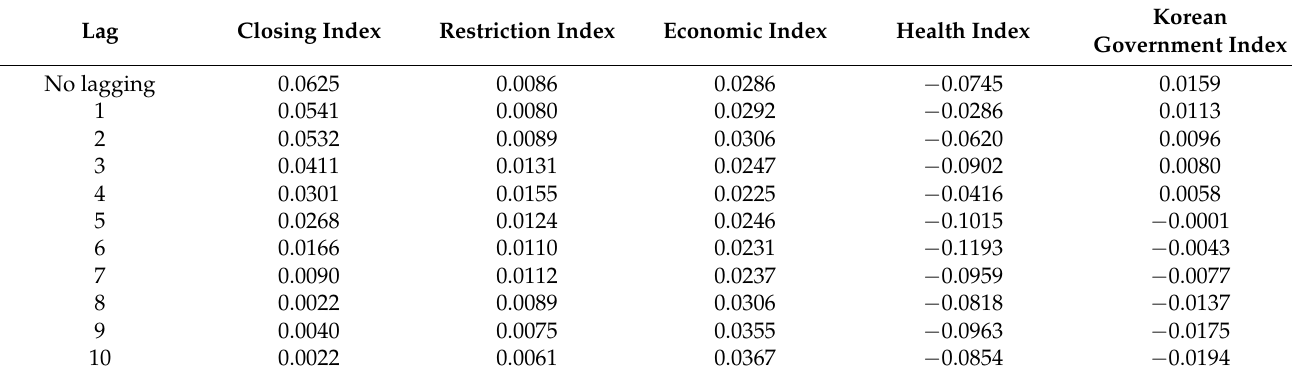
Table 4. Seoul Metropolitan Area’s Coefficients from Multiple Indices Model.